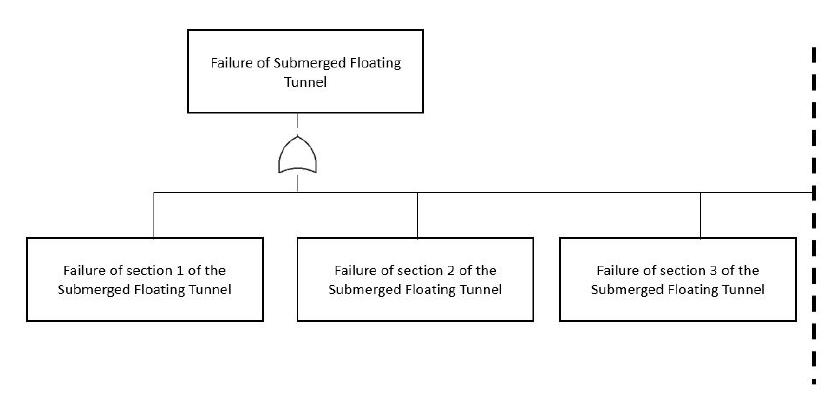
Figure 3. Fault tree for an SFT